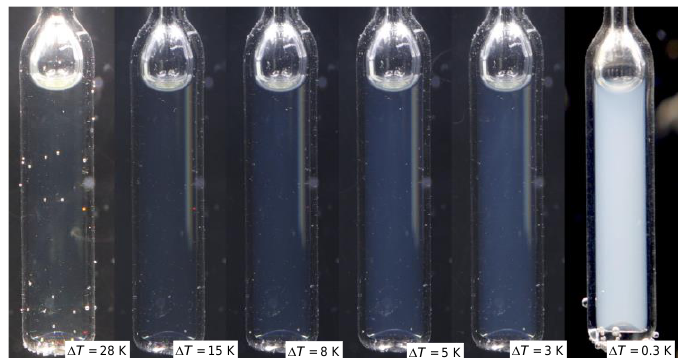
Figure 8. Critical opalescence on cooling towards the critical consolute temperature in MBBA— Isooctane critical mixture, x C = 0.665 mol . f . isooctane; T = T − T C is for the distance from T C .